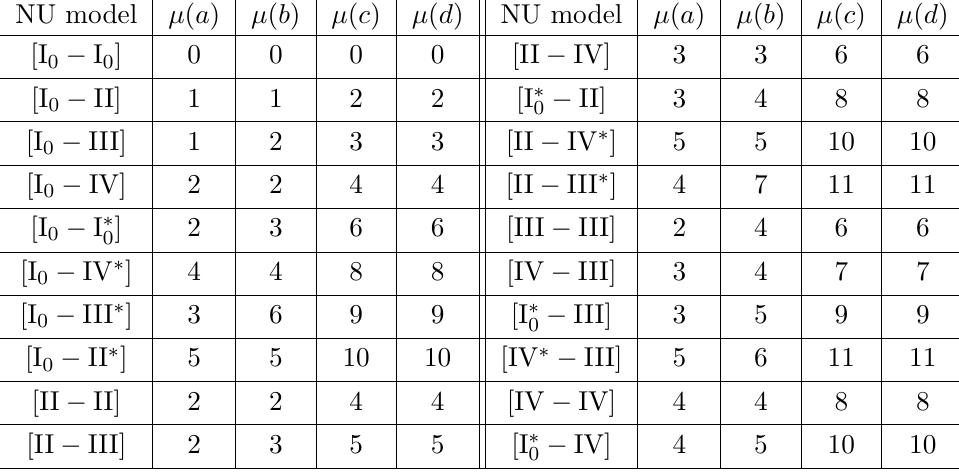
Table 5. Elliptic type 2 resolvable